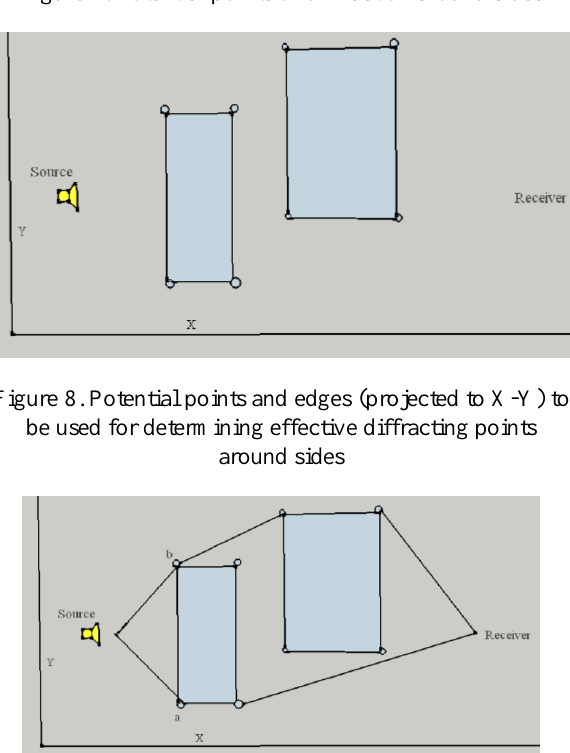
Figure 7. Potential points of diffraction around sides